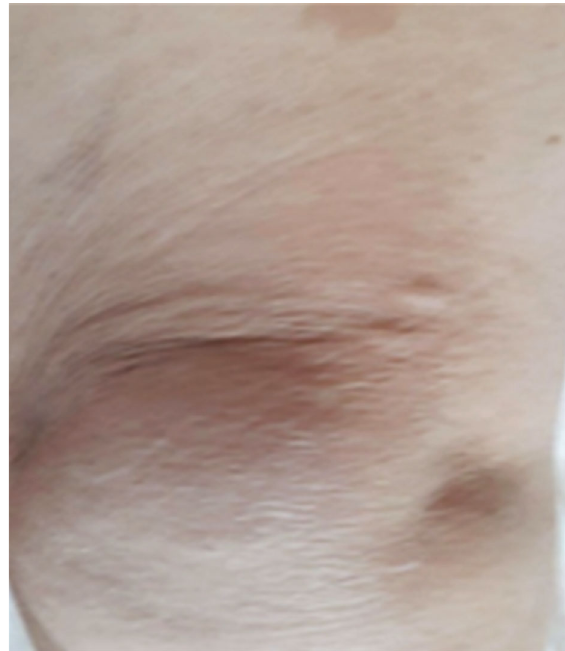
Figure 2: Neuro fi bromas on the anterior